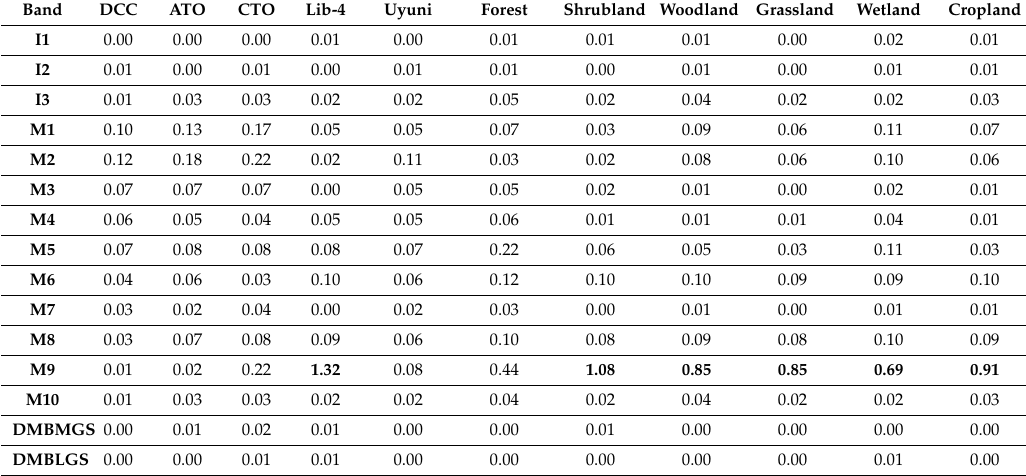
Table 8. NOAA-20 VIIRS V2 RSR Earth-reflected scene-dependent γ for measured 1% extended bandpass limits, shown in